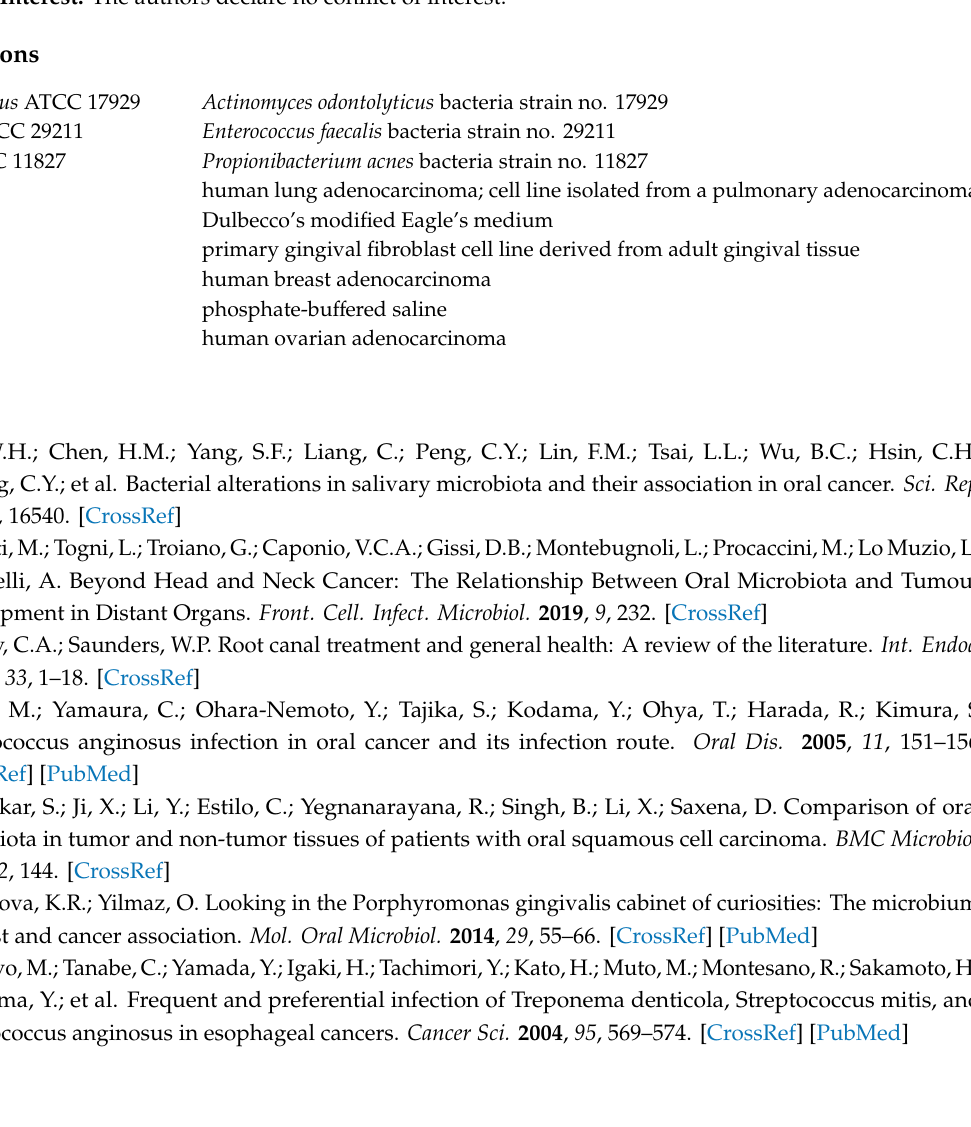
Figure S1: Impact of anaerobic conditions on cancerogenic potential of cultured